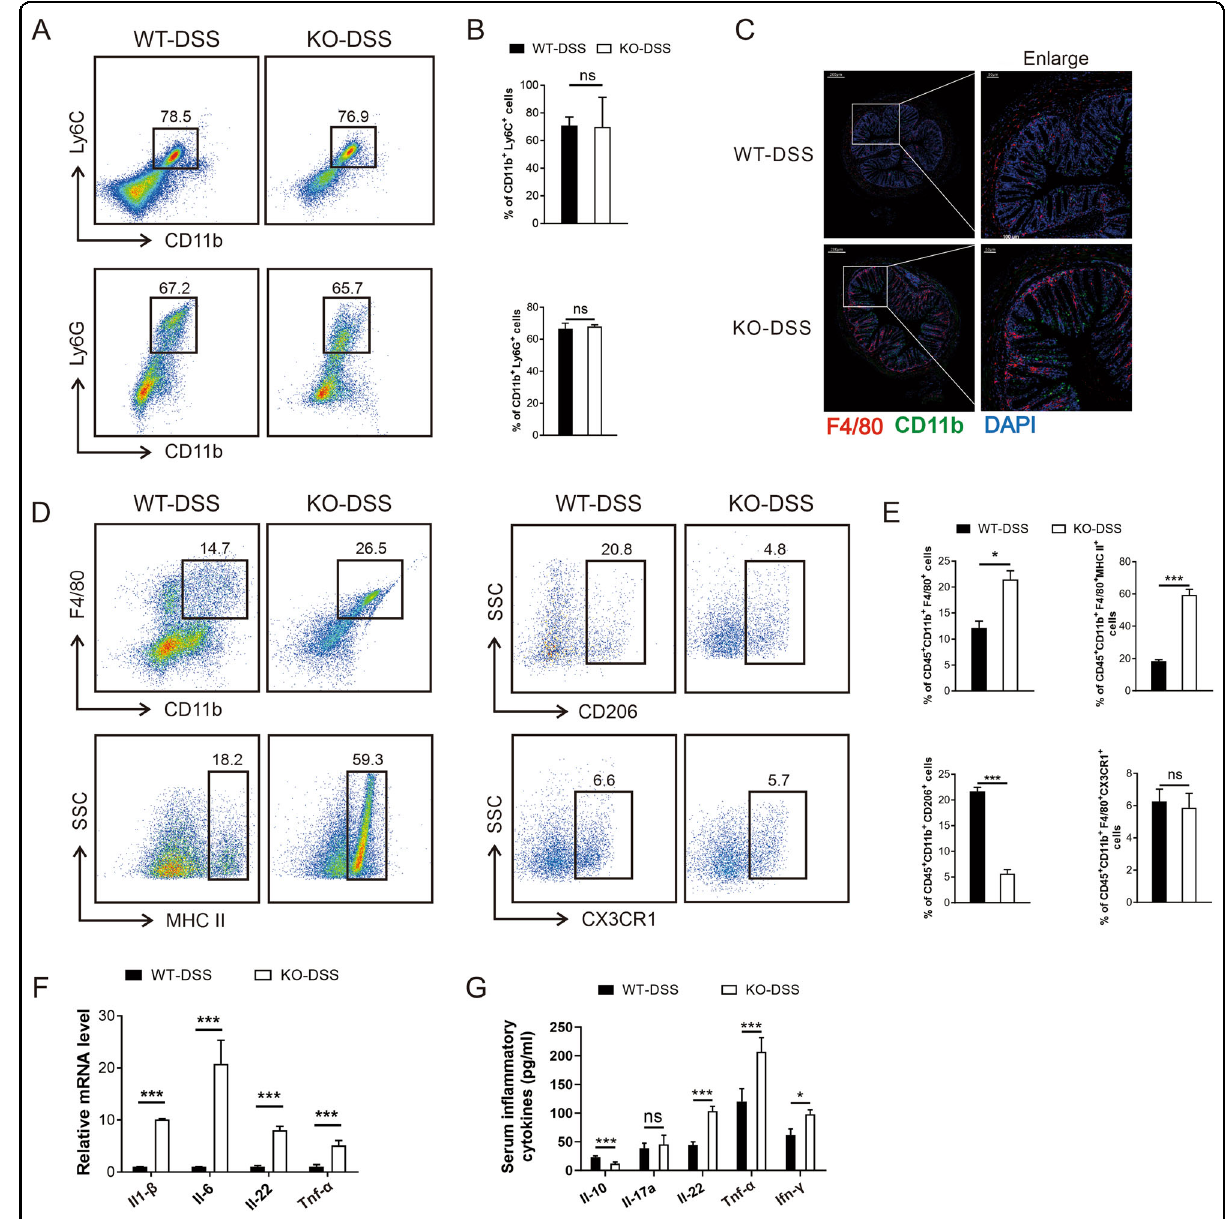
Fig. 2 QKI deletion elevated the proportion of M1 macrophages in the colon. Lymphocytes were sorted from colonic lamina propria (CLP) of WT-DSS and KO-DSS mice and then gated from CD45 + group ( n = 6/group). A The monocytes (CD11b + Ly6C + ) and neutrophils (CD11b + Ly6G + ) were identi fi ed by fl ow cytometry. B The percentage of labeled WT-DSS and KO-DSS monocytes and neutrophils were shown in a summary graph. C F4/80 (red), CD11b (green), and DAPI for nuclei (blue) in colon tissues from WT-DSS mice and KO-DSS mice. Scale bars: 200 μ m (whole colon sections) and 50 μ m (enlarged insets). D The percentages of macrophages (CD45 + CD11b + F4/80 + ) were analyzed by fl ow cytometry. Then the M1- type macrophages (CD11b + F4/80 + MHC II + ), M2 macrophages (CD11b + F4/80 + CD206 + ), and residential macrophages (CD11b + F4/80 + CX3CR1 + ) were gated from CD45 + CD11b + F4/80 + macrophages. E Quali fi cation of macrophages, M1 macrophages, M2 macrophages, and residential macrophages. F q-PCR analysis the mRNA level of cytokines Il-1 β , Il-6 , Il-22 , and Tnf- α in colon tissue. G The expression level of in fl ammatory cytokines including Il-10, Il-17a, Il-22, Tnf- α , and Ifn- γ in peripheral blood serum of mice were detected by ELISA. All bars represent the mean of measurements from three independent experiments, and the error bars indicate ±SEM; * P < 0.05, ** P < 0.01, and *** P < 0.001, “ ns ” indicates not signi fi cant, by unpaired, two-tailed Student ’ s t test ( B , E , F , G